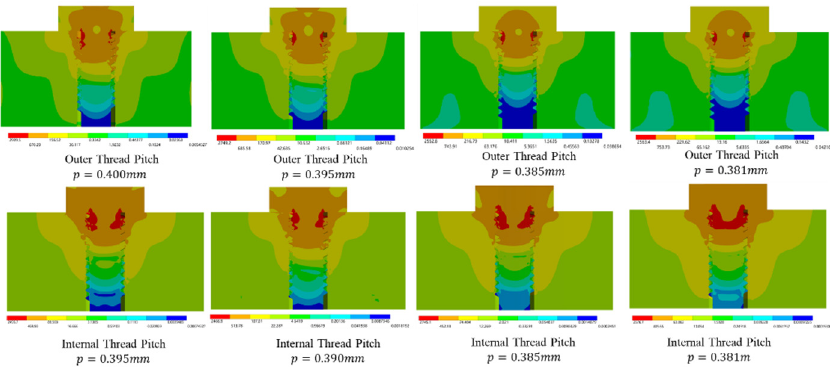
Figure 7. Contact stress distribution under the influence of thread pitch deviation.